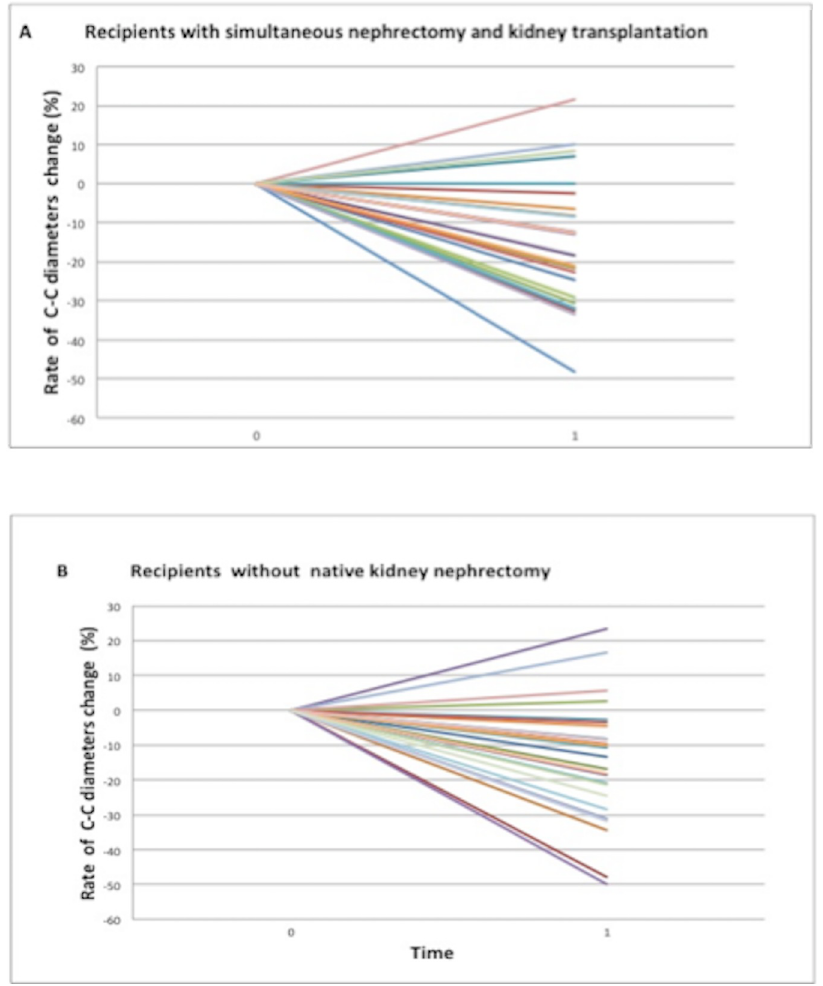
Fig 4. Visual figure demonstrating the rate of change in native kidney longitudinal diameters after transplantation compared to pre-transplant evaluation. The rates of change were equally statistically significant for patients who underwent simultaneous nephrectomy and kidney transplantation (A) and patients who underwent the kidney transplantation alone (B).